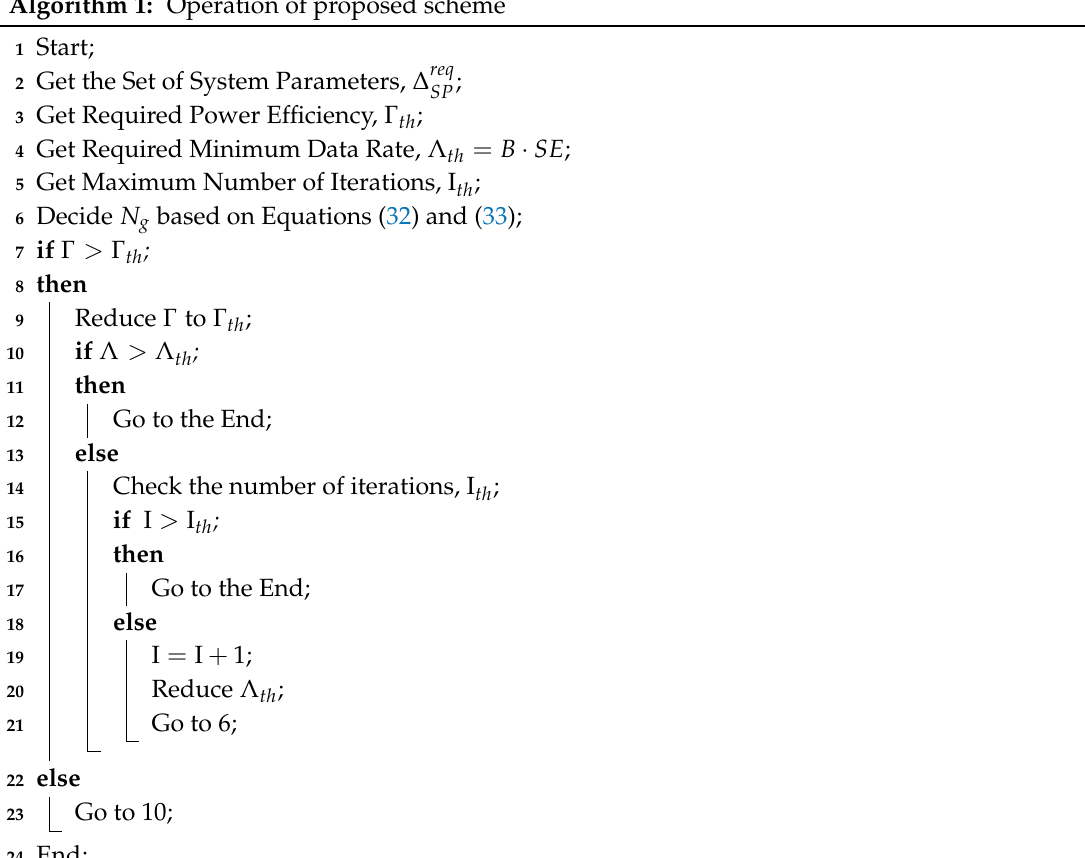
Figure 4. Example of operation flow chart. Algorithm 1: Operation of proposed